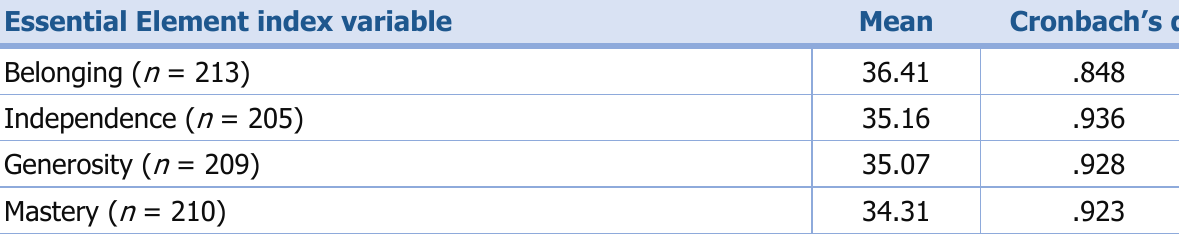
Table 8. Essential Element Index Variables Essential Element index